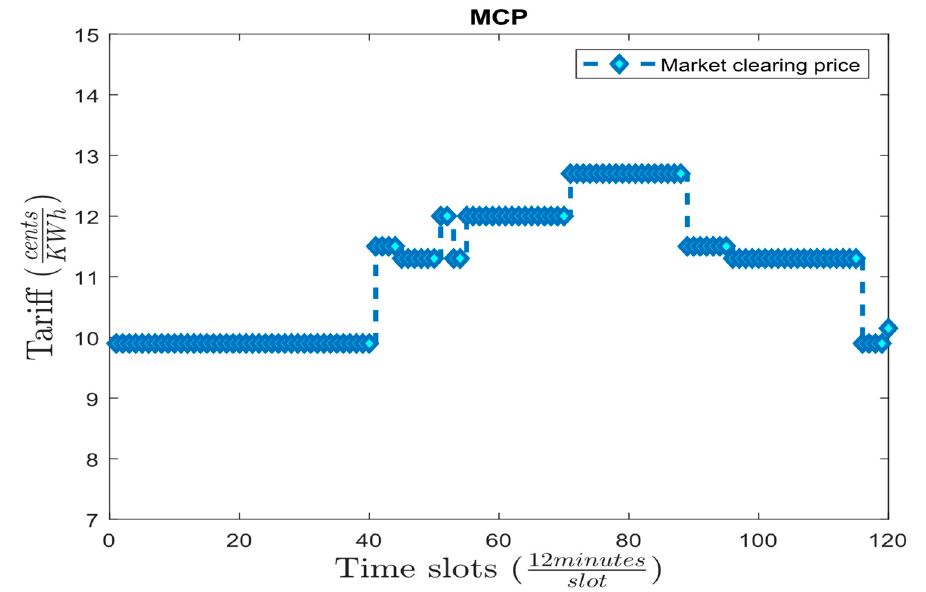
Figure 28. MCP determined for energy trading in LETM for scenario 3.